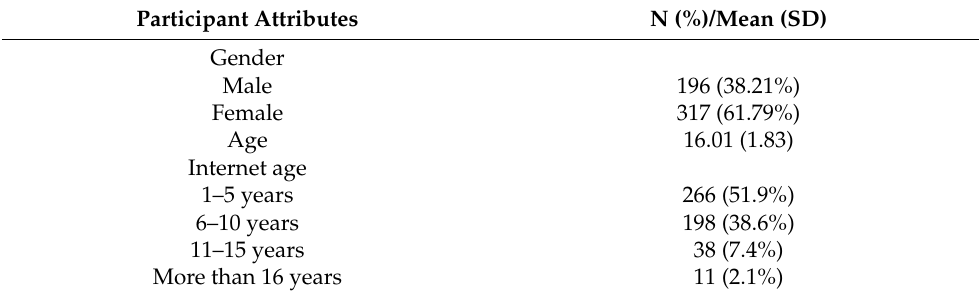
Table 1. Descriptive statistics of the